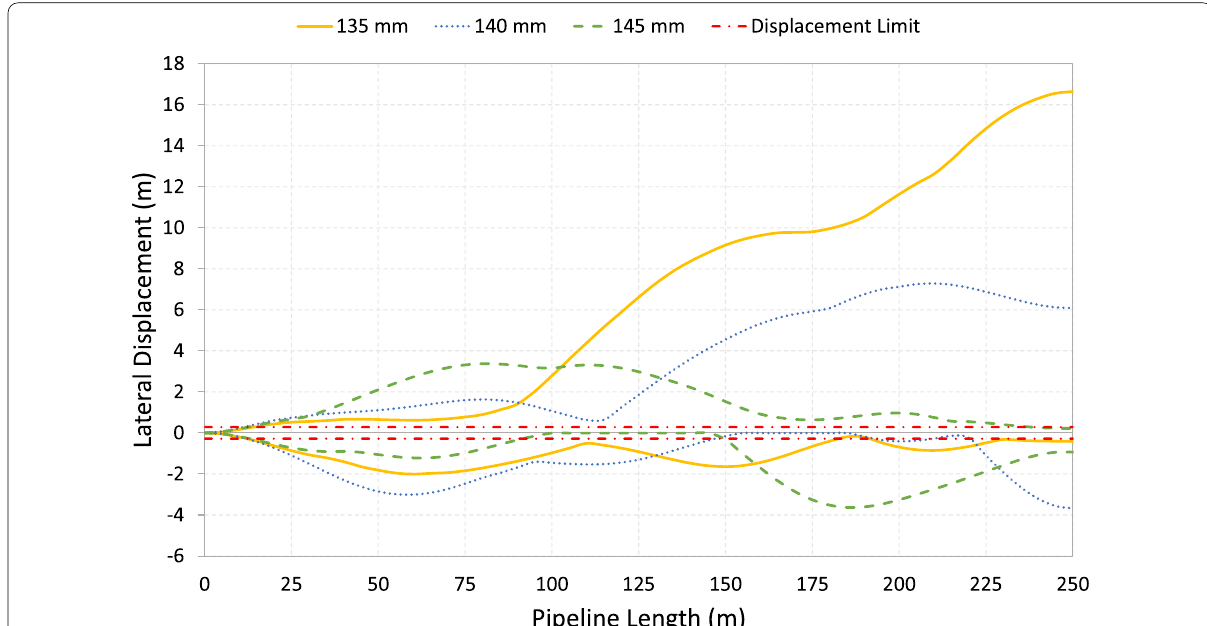
Fig. 3 Envelopes of the lateral displacements of the pipeline for concrete thickness range 135–145 mm (1-year RPV wave